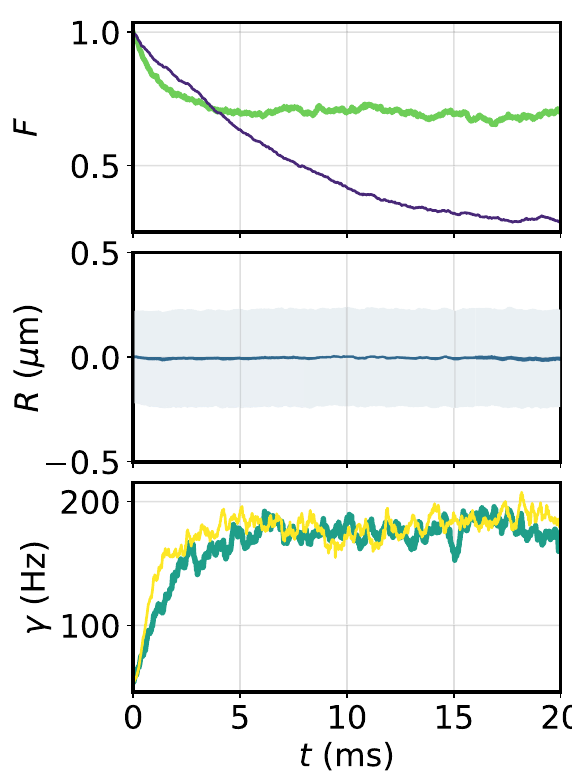
FIG. 6. The coupled spin-motion Monte Carlo simulation of the qubot, 10 3 quantum trajectories. Top: average fidelity to the | φ + (cid:3) Bell state as a function of time for the qubot plus a depo- larizing channel (thick green line) compared to the action of a depolarizing channel alone (thin purple line). Middle: the aver- age position of the atom with corresponding quantum uncertainty (light blue shade). Bottom: the average correction rates γ L 1 (light yellow line) and γ L 2 (thick green line). The parameters used in the plot are as follows: decoherence rate (cid:15) = 100 Hz, trap frequency = 1 kHz, damping rate κ = 0.1 ms × ω 2 ω , initial t t